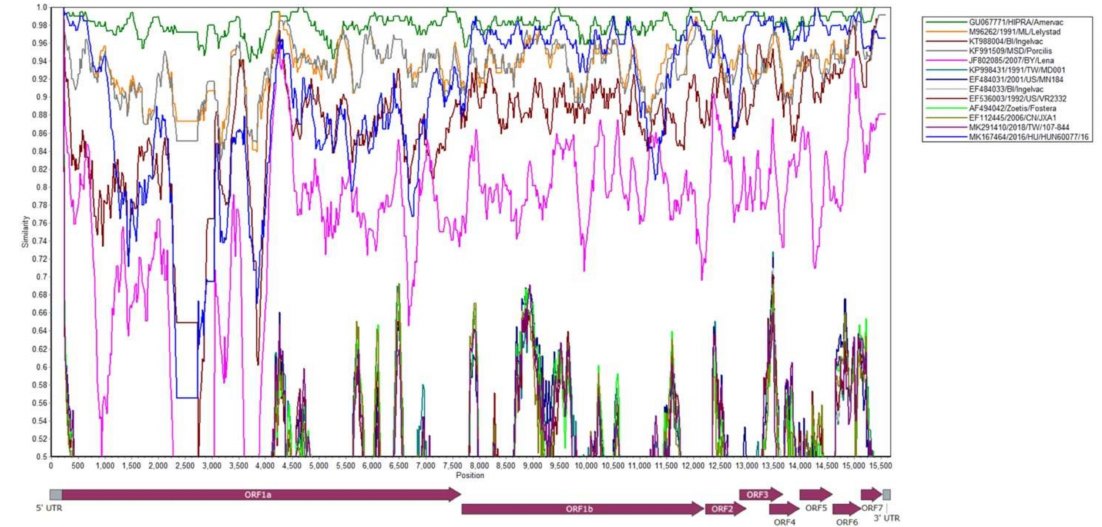
Figure 3. Nucleotide sequence similarity of the complete genome of PRRSV / NPUST-2789-3W-2 / TW / 2018 with that of other PRRSVs.